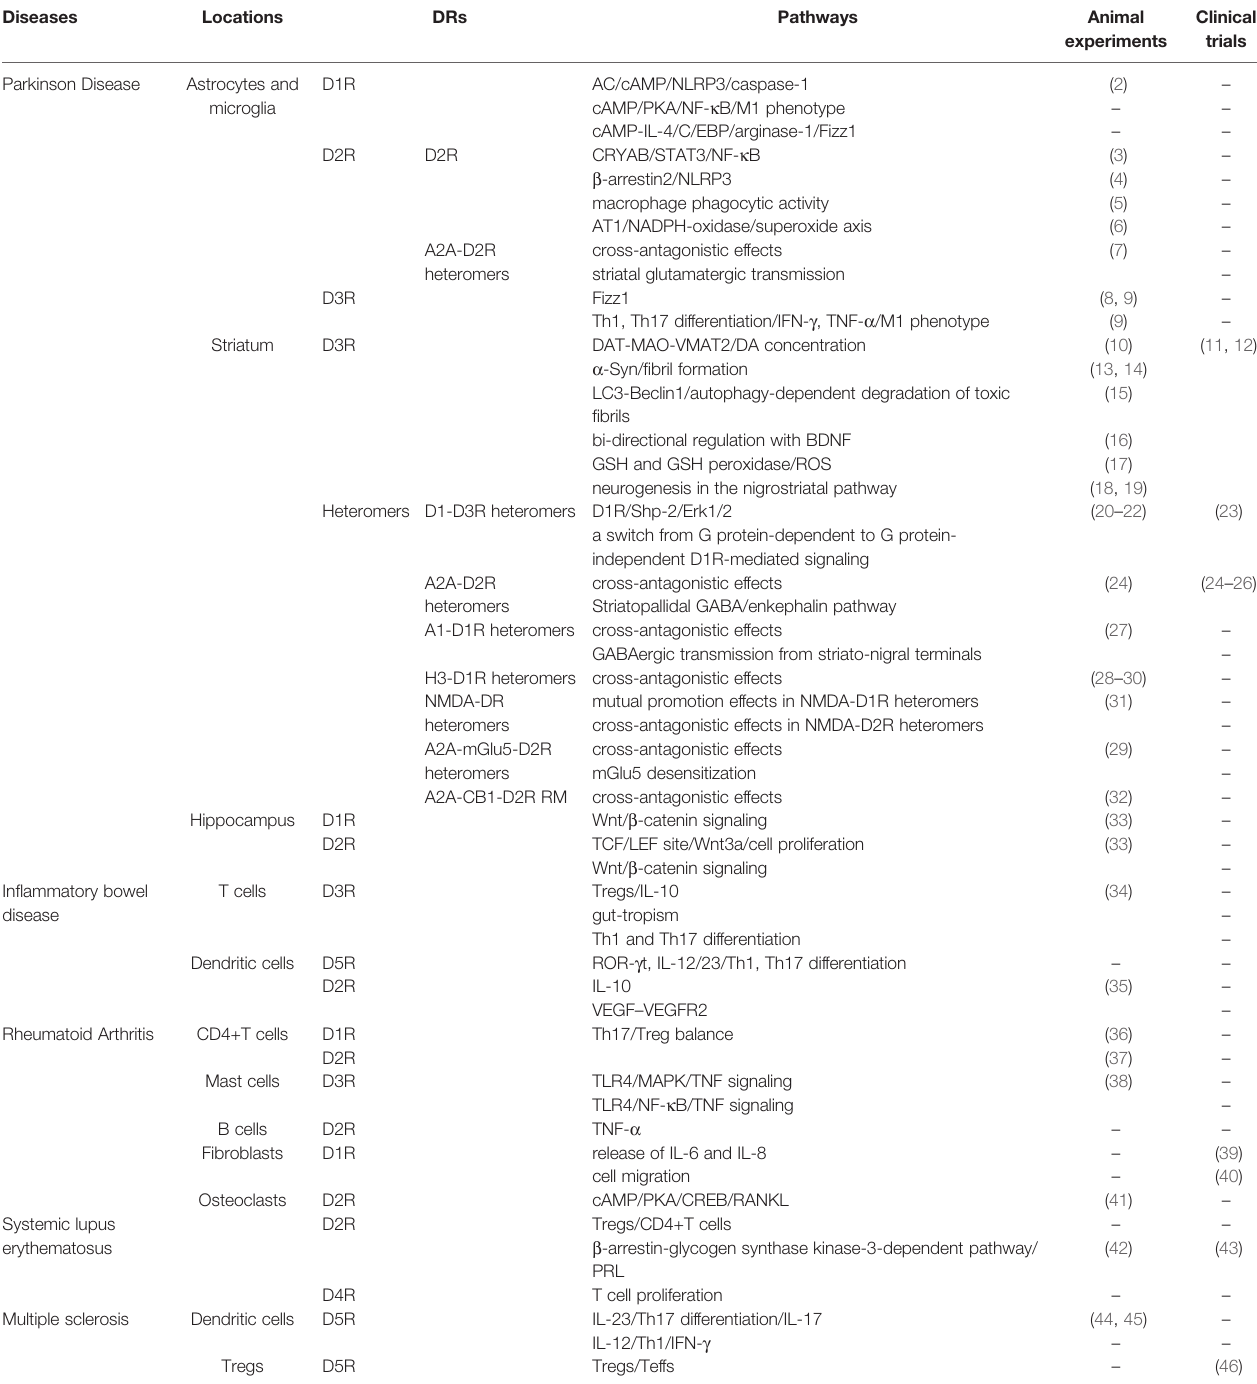
TABLE 1 | Dopamine receptor-mediated signaling pathways in in fl ammatory